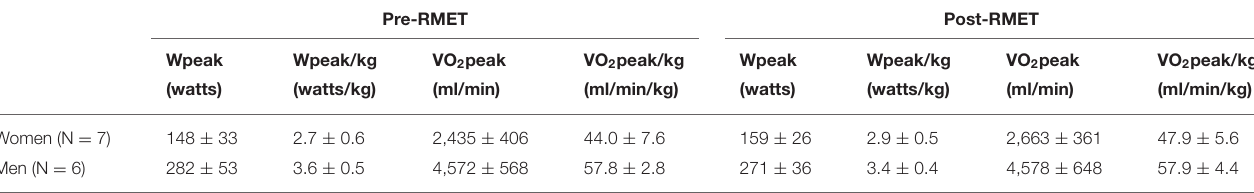
TABLE 1 | Results of cardiopulmonary exercise testing (CPET).